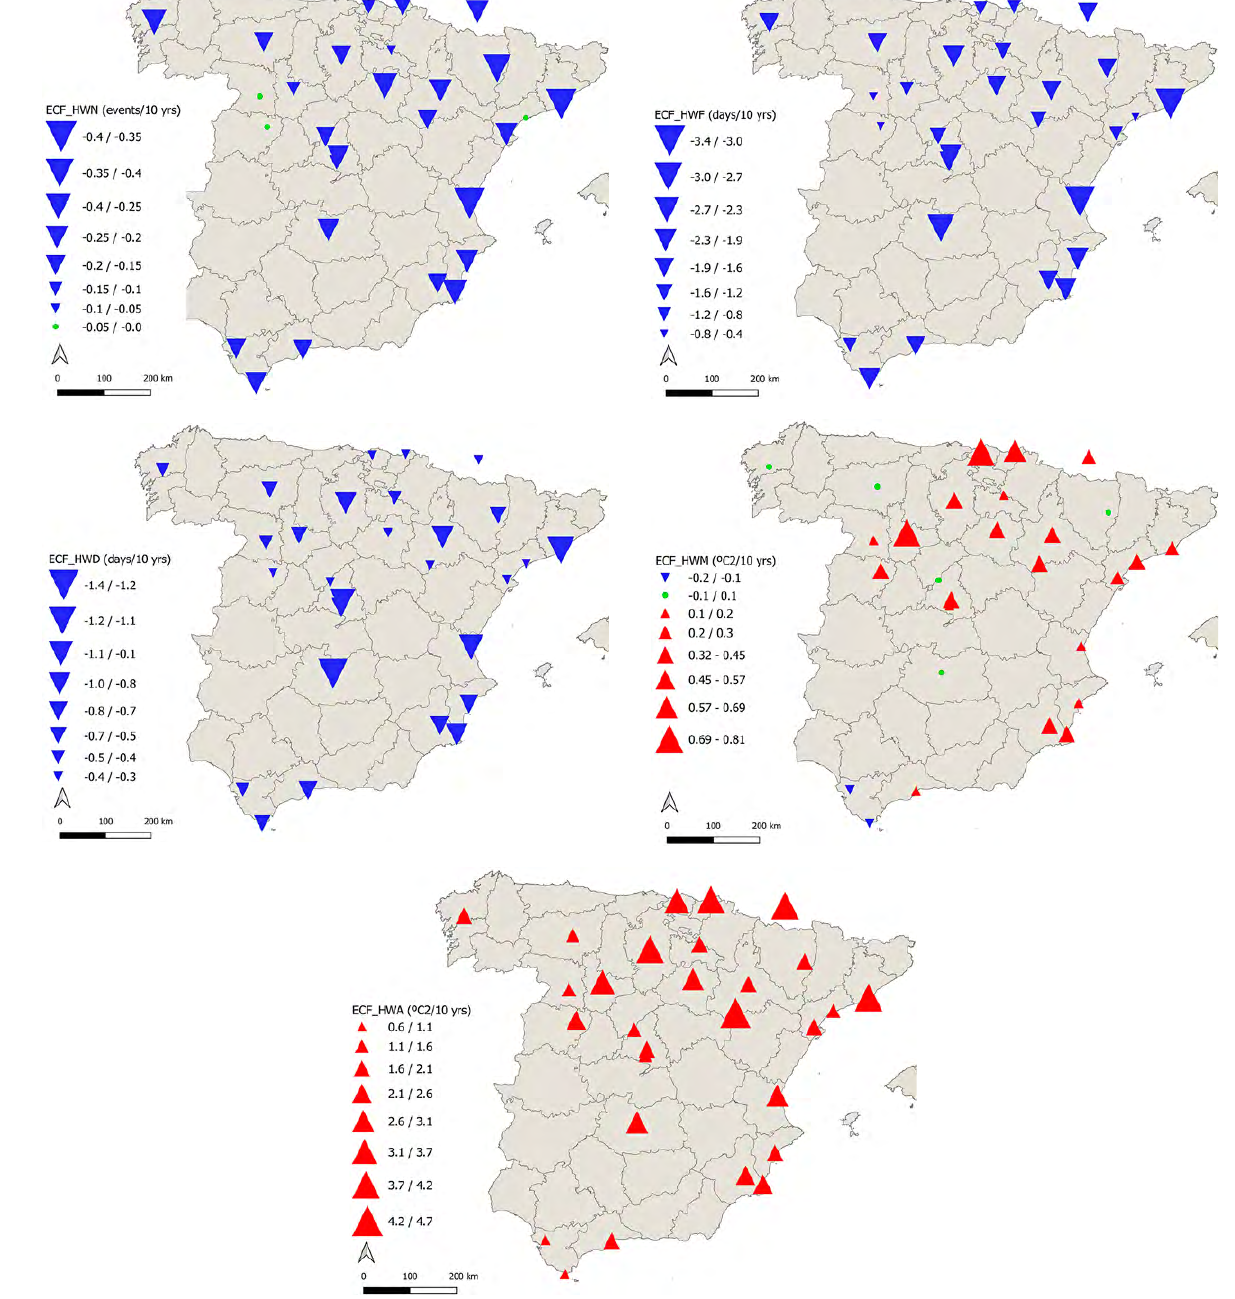
Figure 6. Maps of the spatio-temporal annual trends of the coldwave indices (ECF_HWN, ECF_HWF, ECF_HWD, ECF_ HWM, and ECF_HWA) for the period